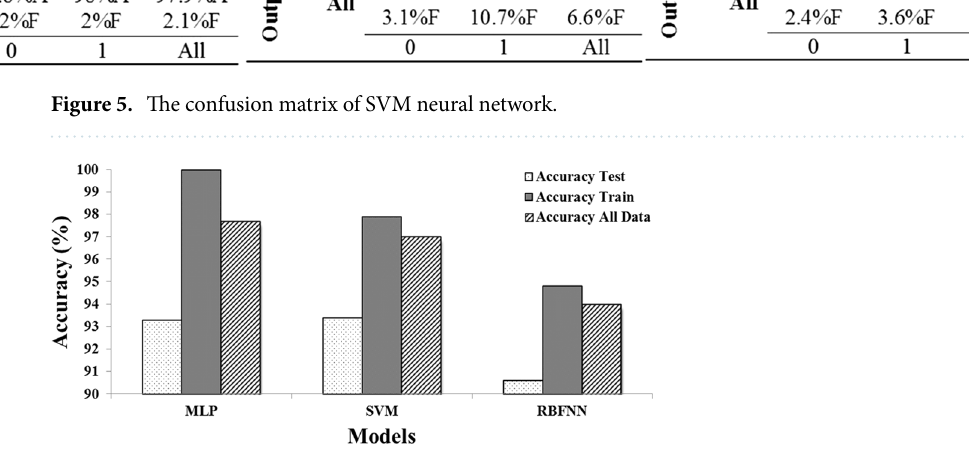
Figure 6. The performance of the designed TFMs for susceptible trees identification.